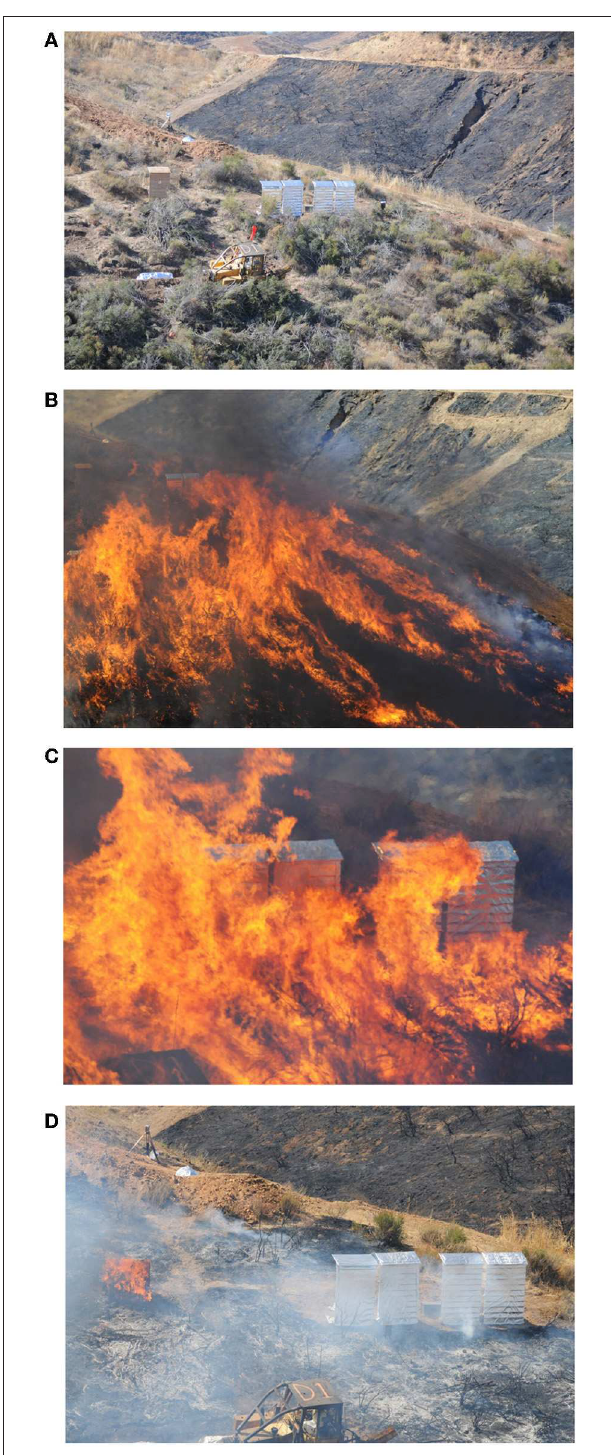
FIGURE 6 | Photographs of Burn #2. (A) Four wall-and-eave wood structures covered with different fire blankets (center; see Table 4 ) and another wood structure covered with wire mesh screen (left) standing on the slope (B,C) , the fire front is approaching and engulfing the structures, and (D) the undamaged four wood structures (right) and the burning wire mesh-covered structure (left) after the prescribed burn (see Supplementary Videos 1 , 2 ).